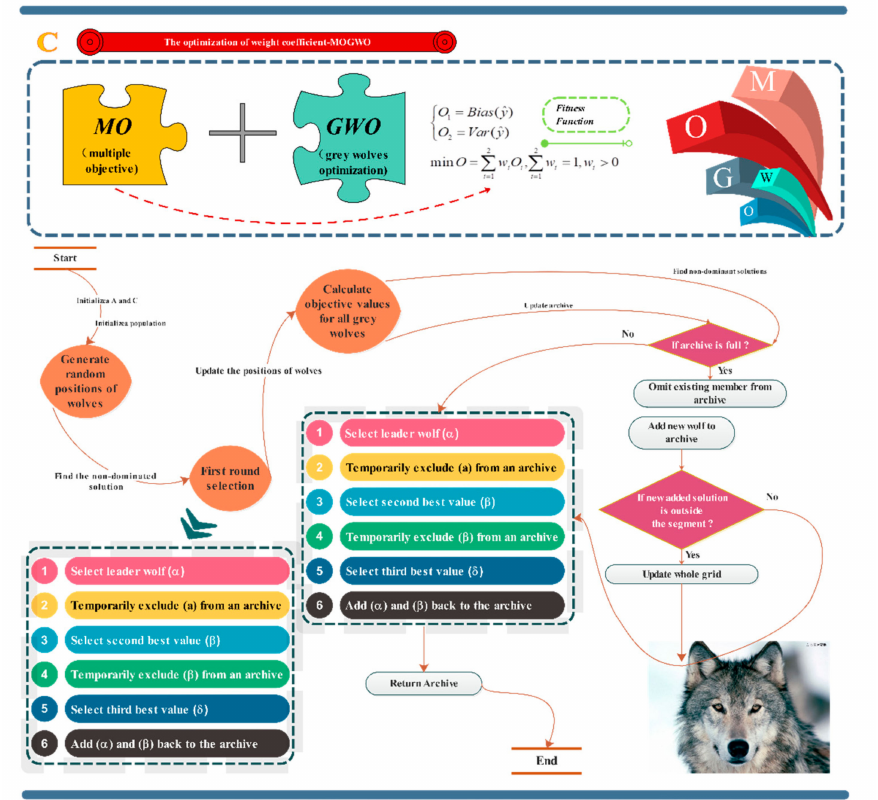
Figure 4. Position updating mechanism of search agents and the e ff ects of A on